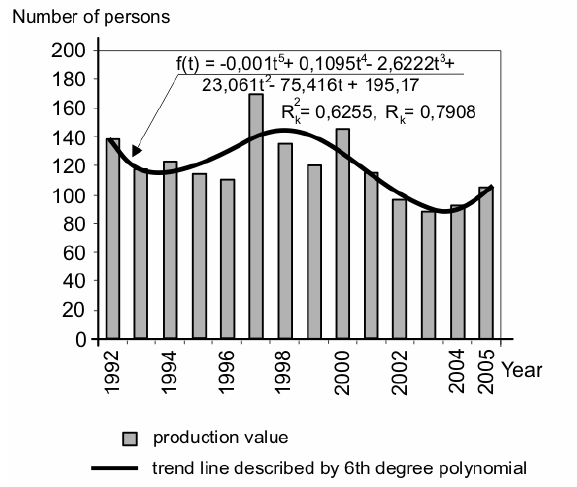
Fig 2. Number of victims of fatal accidents at work in